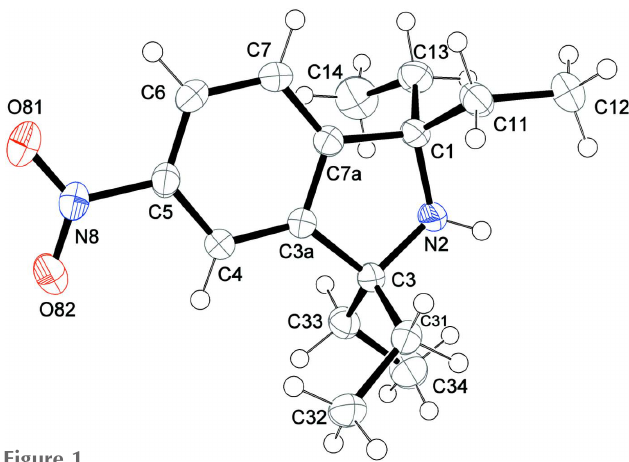
Figure 1 The molecular structure of the title compound with displacement ellipsoids drawn at the 50% probability